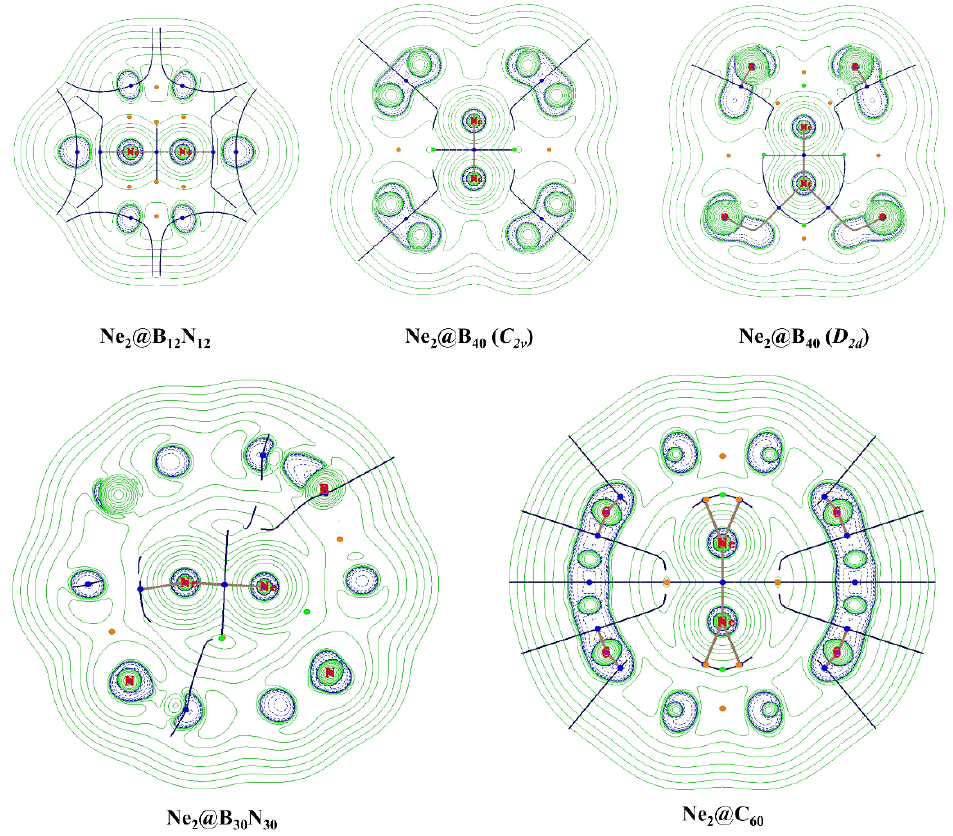
Figure 2. Contour diagrams of the Laplacian of the electron density of the Ne 2 @cage systems. Green solid and blue dashed lines stand for positive and negative Laplacian, respectively. Table 4. Topological descriptors (a.u.) at the bond critical points (BCPs) between Ng atoms in Ne 2 @cage systems.